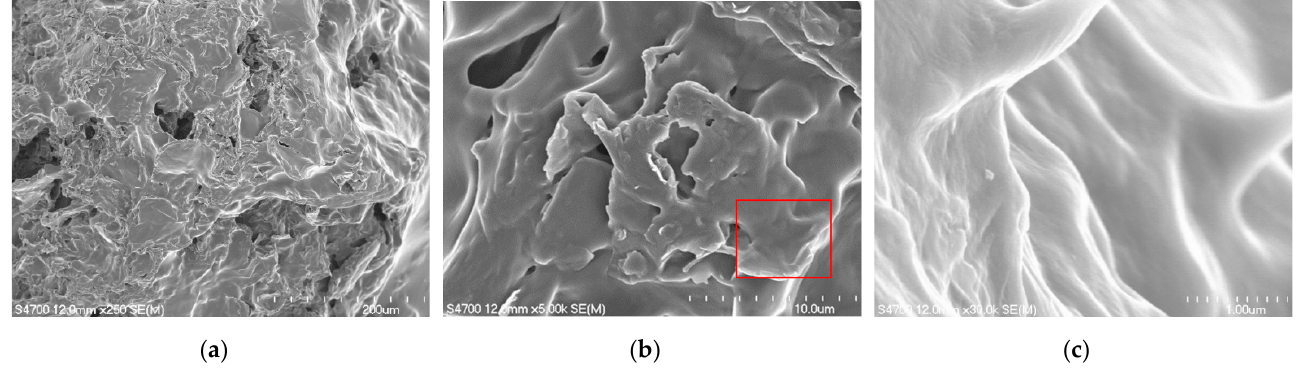
Figure 4. Top view FE-SEM images of the rGO/DPP2T-TT film: ( a ) 250 × ; ( b ) 5000 × ; and ( c ) 30,000 ×